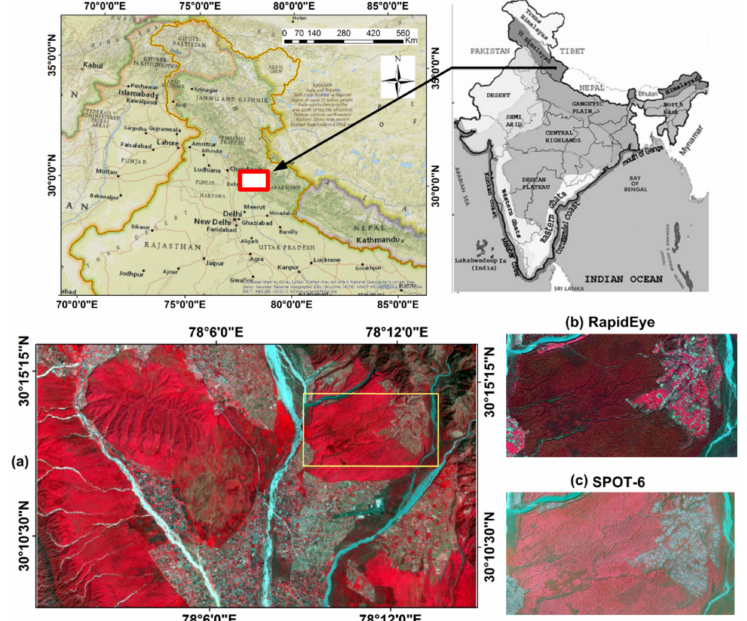
Figure 1. Study area location ( a ) Landsat-8 imagery with larger extent and yellow box showing the smaller extent of ( b ) RapidEye and ( c ) SPOT-6 multispectral